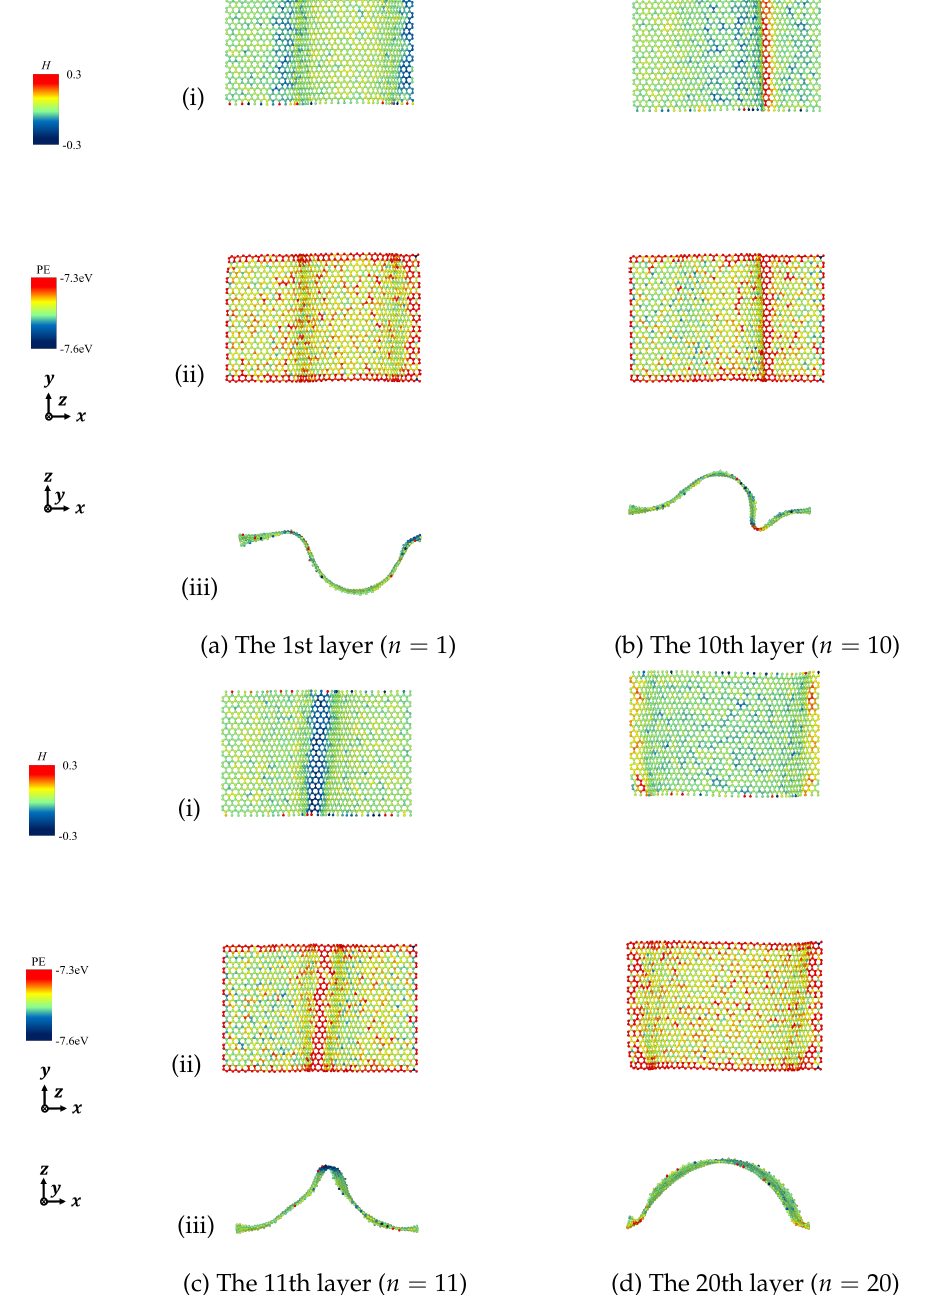
Figure 14. Mean curvature and site potential energy of curved surface of zigzag graphite under compression ε = 0.20. (i) Site mean curvature, (ii) Site potential energy, and (iii) Mean curvature with deformation.